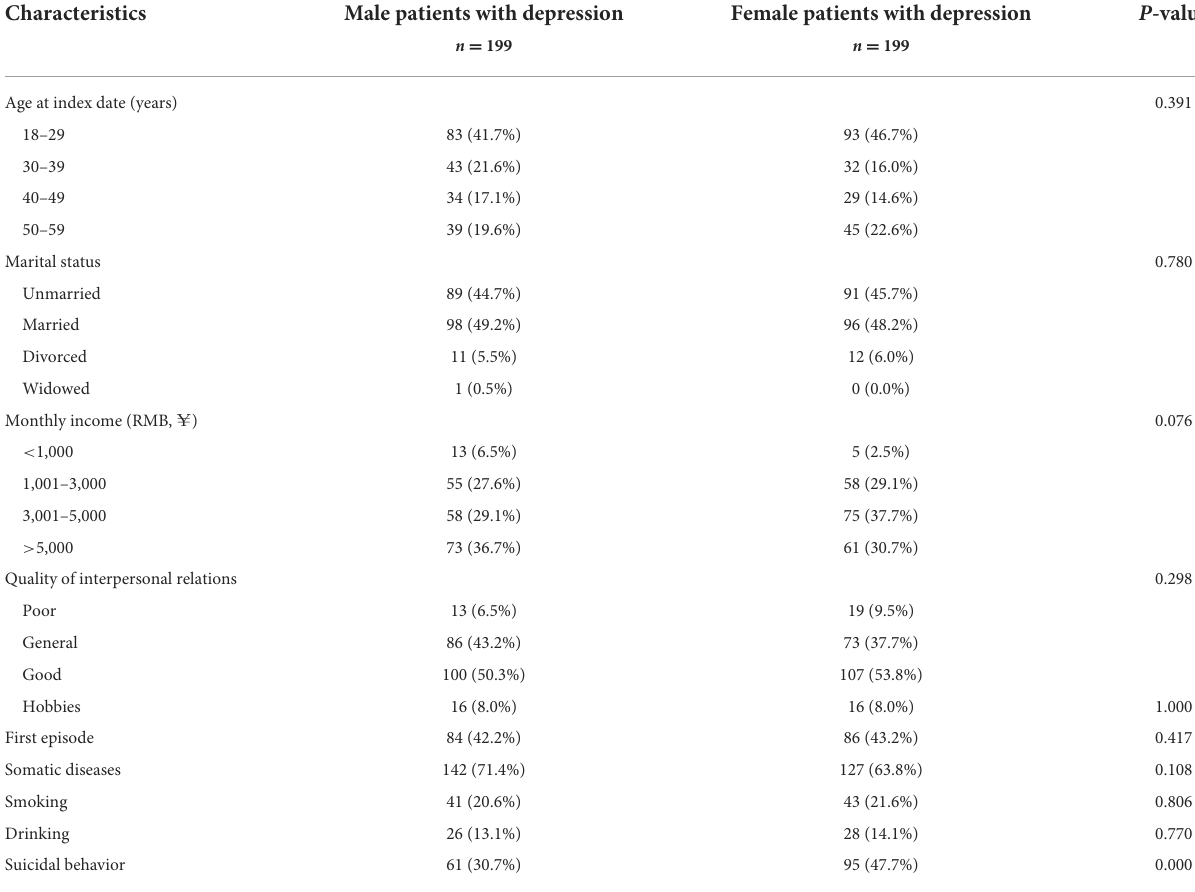
TABLE 3 Characteristics of cases of depression of different genders by propensity score matching.